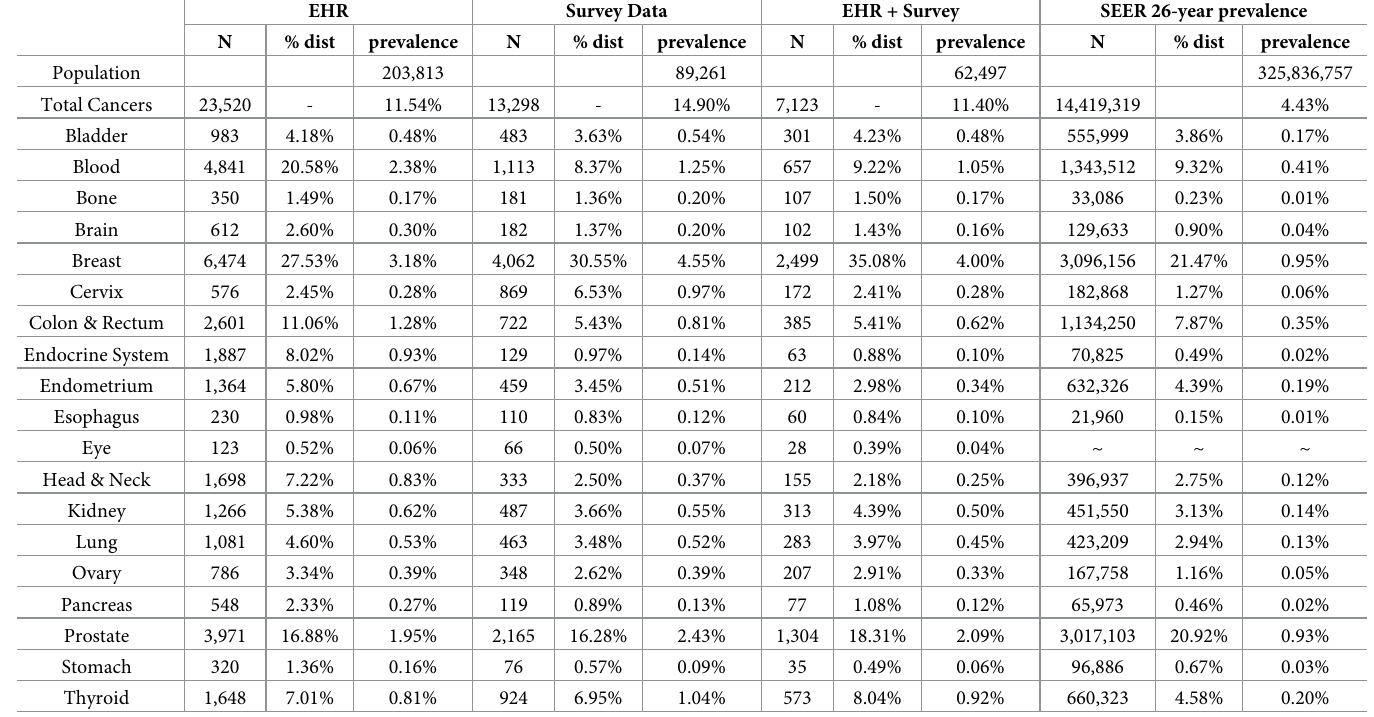
Table 4. Comparison of relative distribution and prevalence of cancer cases by type in the All of Us Research Program to SEER’s 26-year limited duration prevalence. EHR Survey Data EHR + Survey SEER 26-year